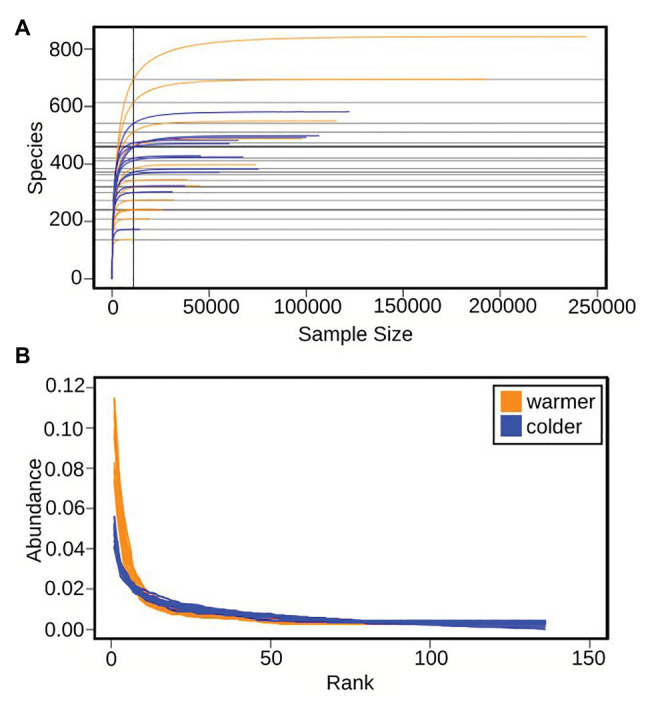
Diversity measures of 16S ASVs, excluding ASVs annotated as chloroplasts. (A) Rarefaction curves, plotting sample size vs. number of ASVs. (B) Normalized rank abundance curves, plotting ASVs, ranked by abundance vs. abundance (counts). Orange – warmer period, blue – colder period.